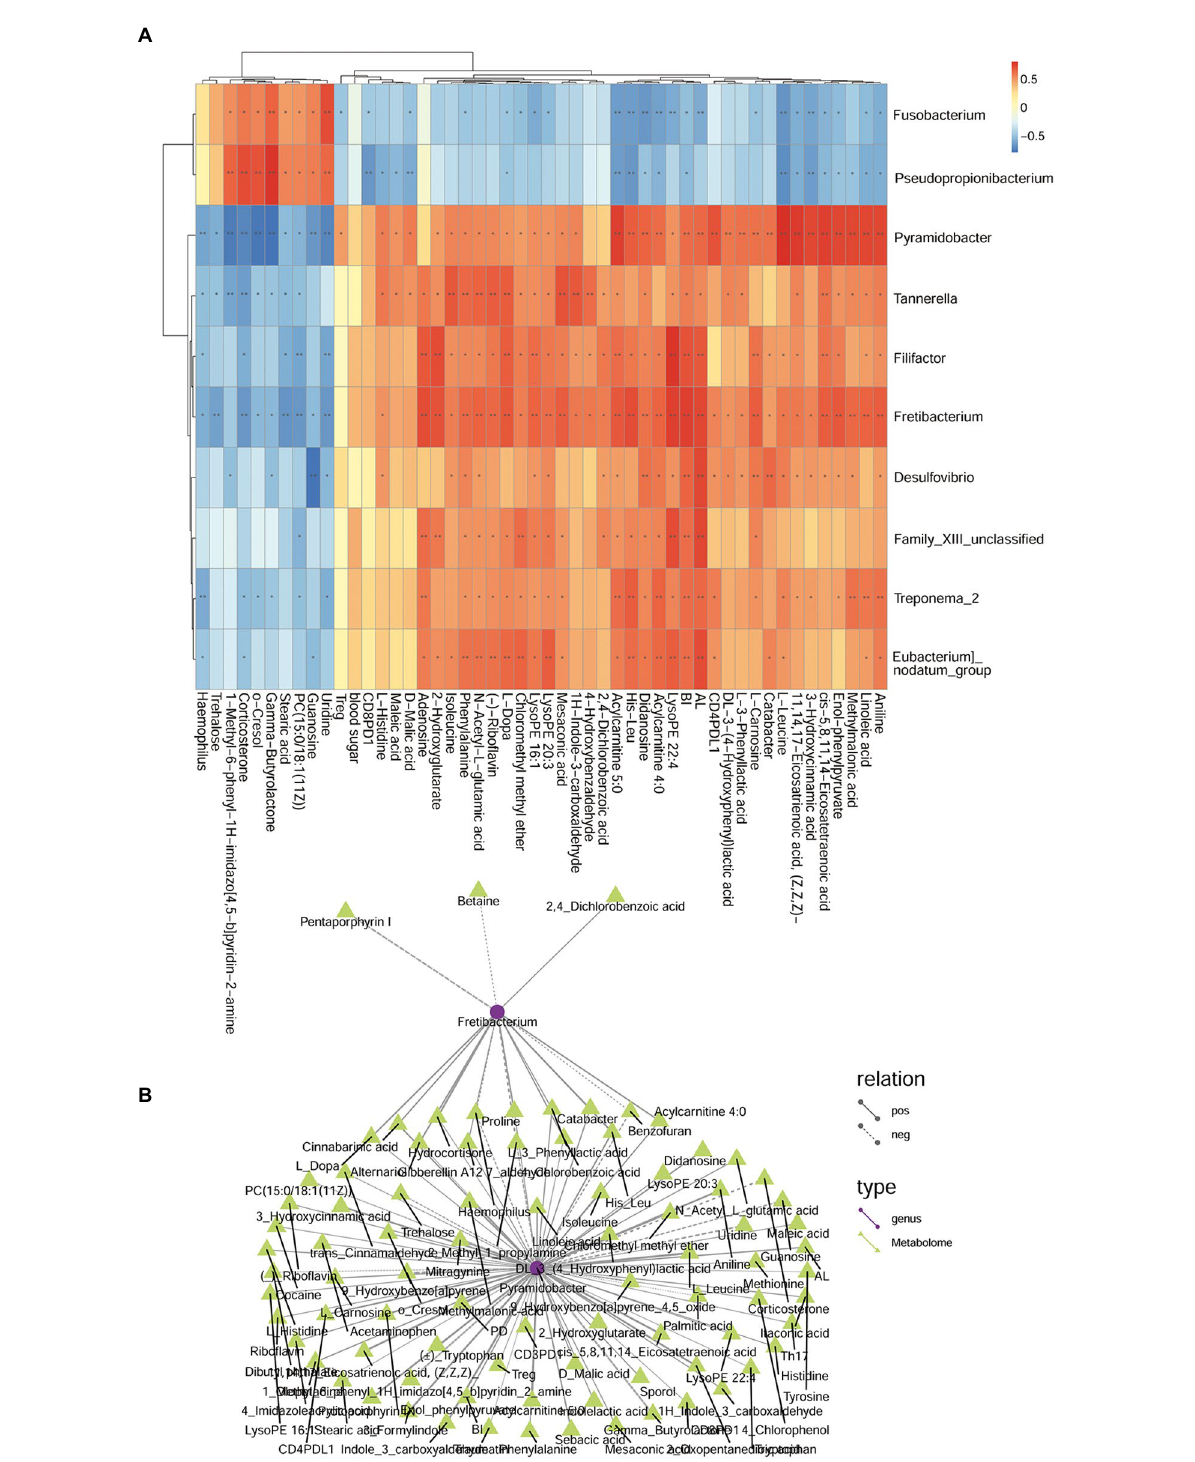
FIGURE 13 The relationship among genera, metabolites, and clinical index of P and H groups. (A) Correlation between differential bacteria and metabolites, with clinical indicators. Red indicates positive correlation, blue indicates negative correlation (* p < 0.05, ** p < 0.001). (B) Network relationship among differential genera, metabolites, and clinical index of DP and DNP groups. The connection between the microbiota and metabolites represents a correlation between them; the solid line represents a positive correlation, and the dotted line represents a negative